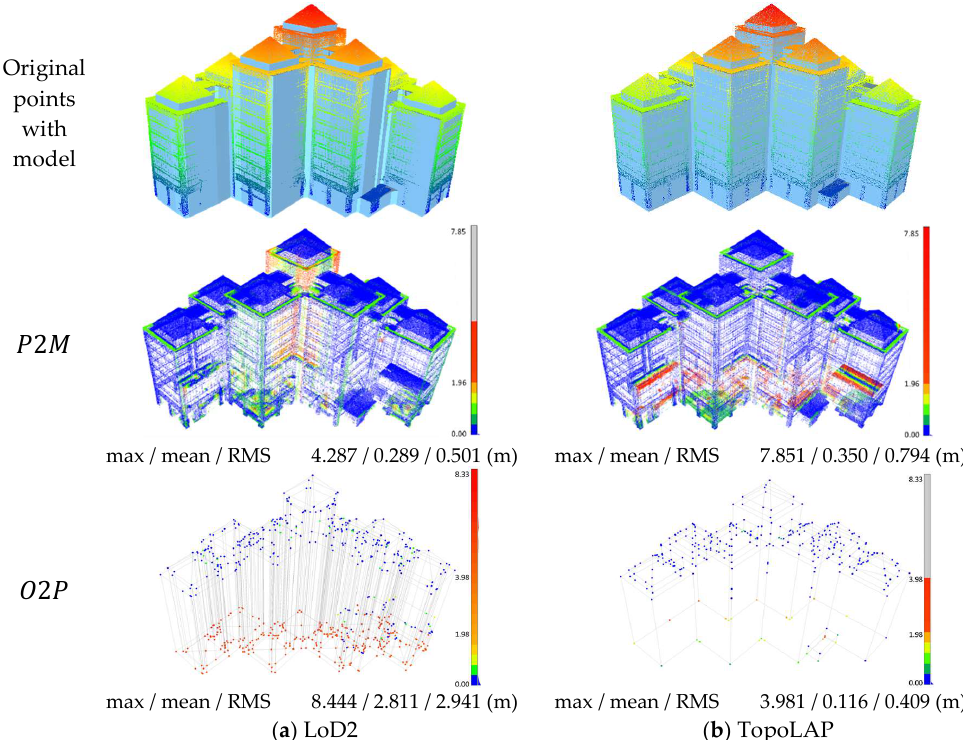
Figure 13. Visualization of the distance evaluation for Dublin1 compared to the LoD2 model.